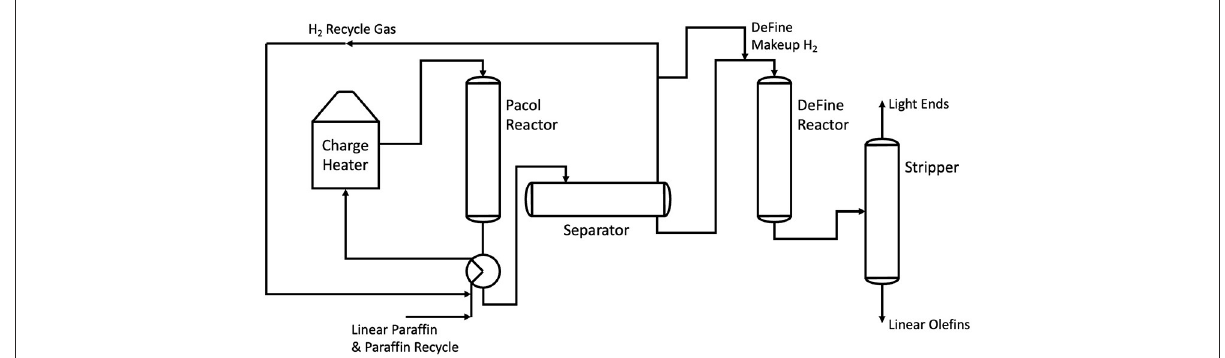
FIGURE3 A process flow diagram showing the Pacol and DeFine reactors in series. Adapted from Meyers